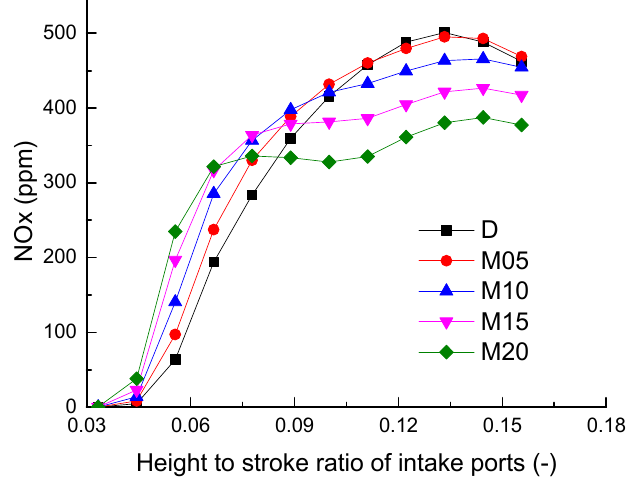
Figure 5. NOx under different HSRs of intake ports. Figure 6 indicates the soot concentration under different HSRs of intake ports. Before